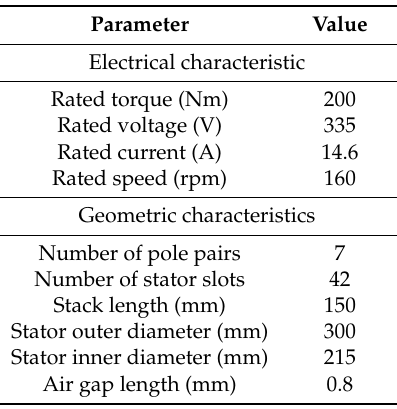
Table 4. Prototype SynRM characteristics.